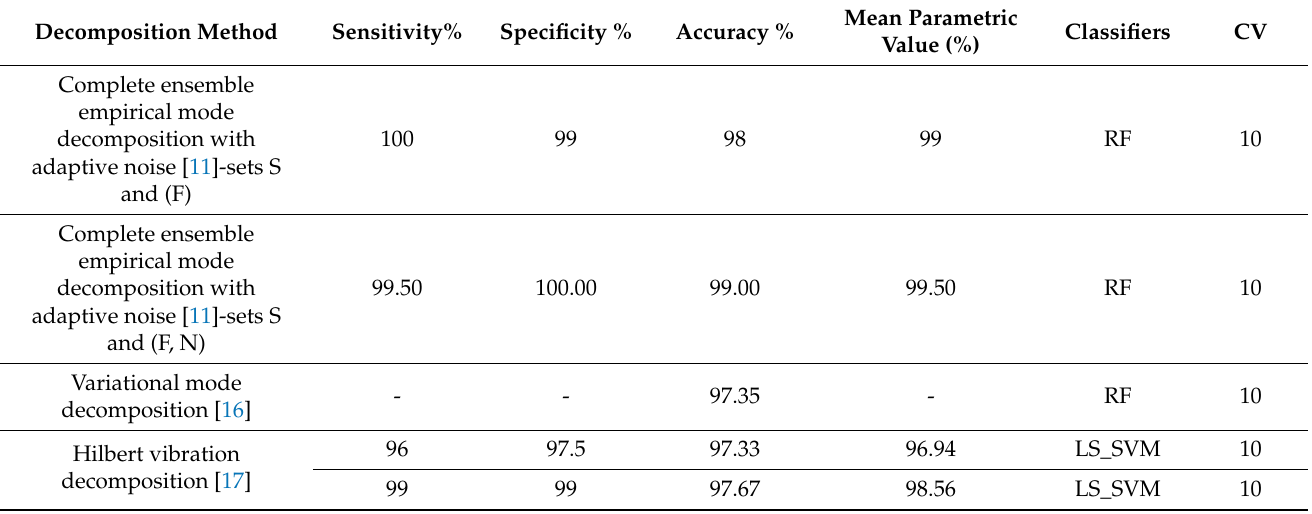
Table 3. Performance comparison of EMD-based seizure detection method for epileptic